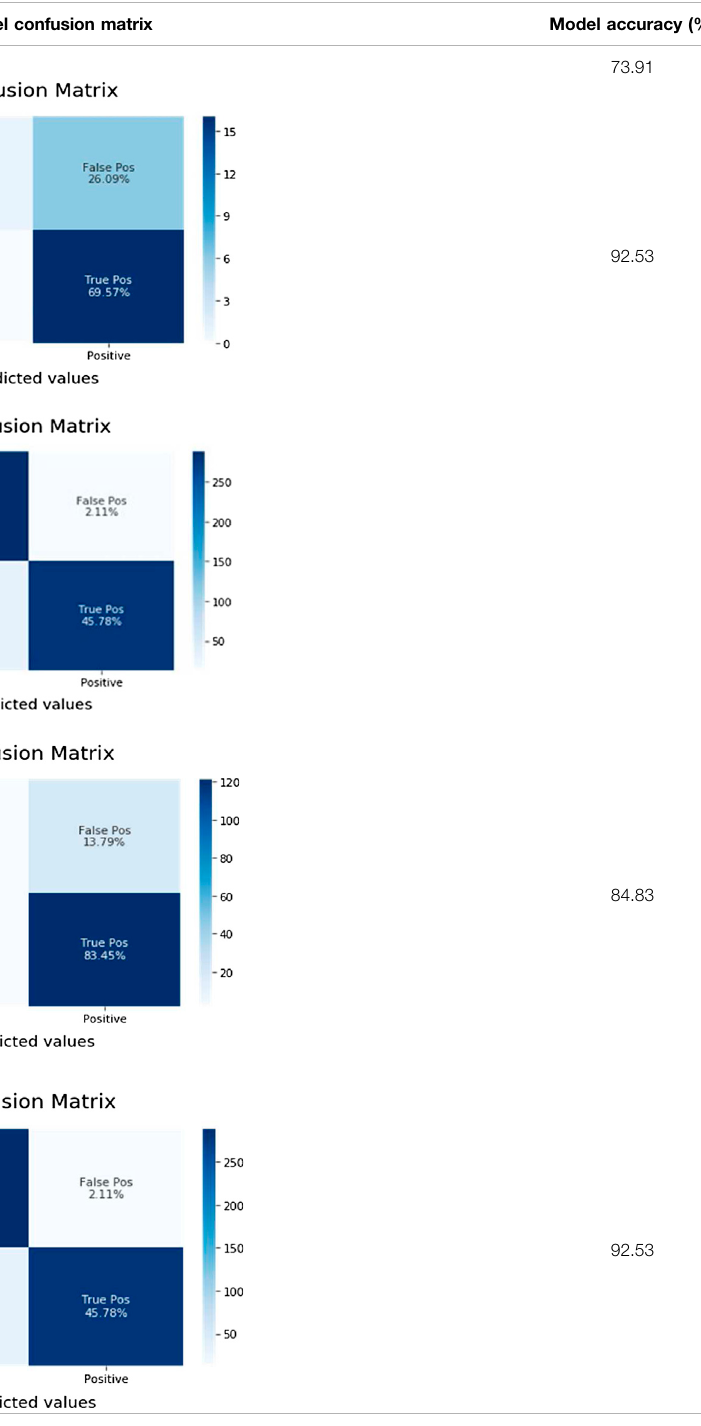
TABLE 4 | Confusion matrix and model